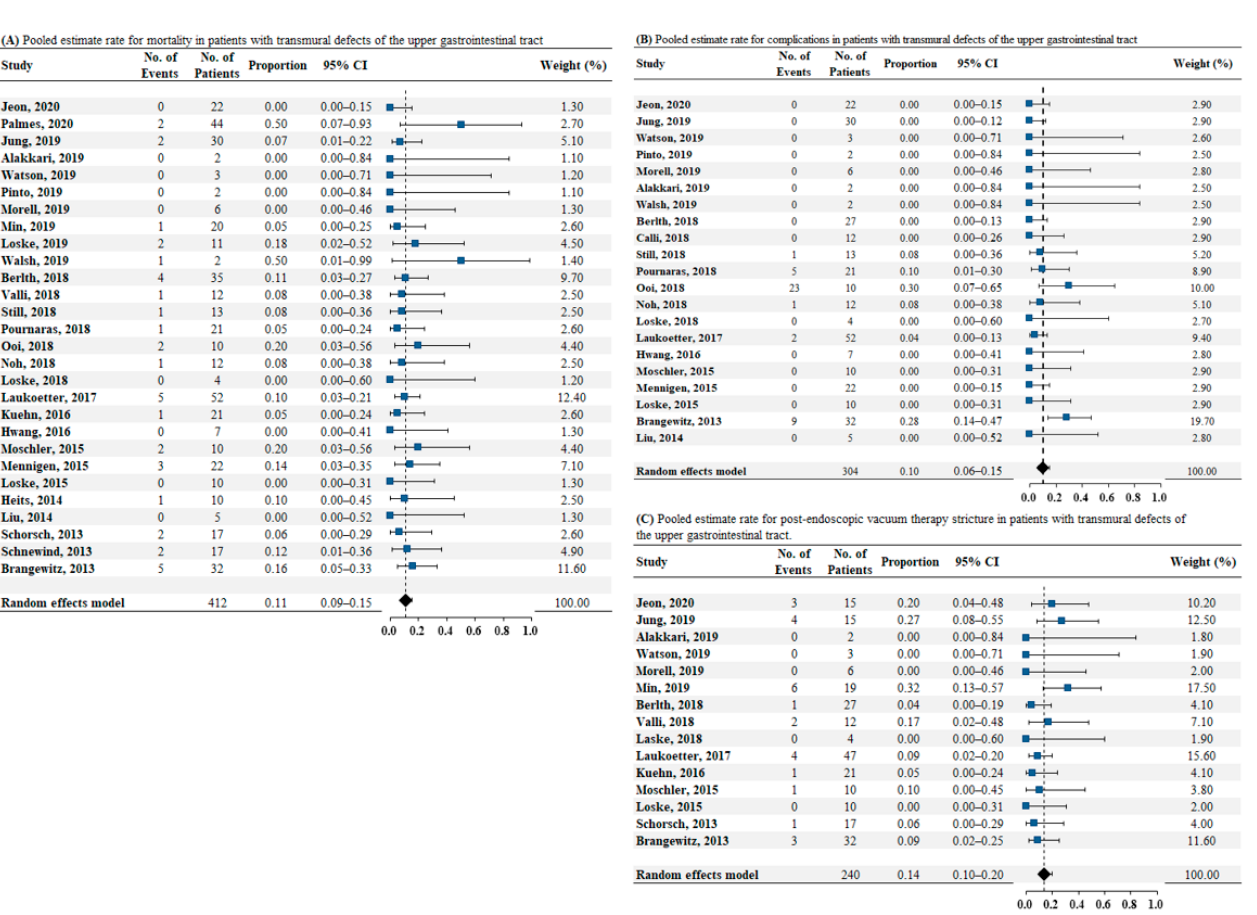
Figure 3. ( A ) Pooled estimate rate for mortality in patients with transmural defects of upper gastrointestinal tract. ( B ) Pooled estimate rate for complications in patients with transmural defects of the upper gastrointestinal tract. ( C ) Pooled estimate rate for postendoscopic vacuum therapy stricture in patients with transmural defects of upper gastrointestinal tract. Abbreviations: No, number; OR, odds ratio; CI, confidence interval.